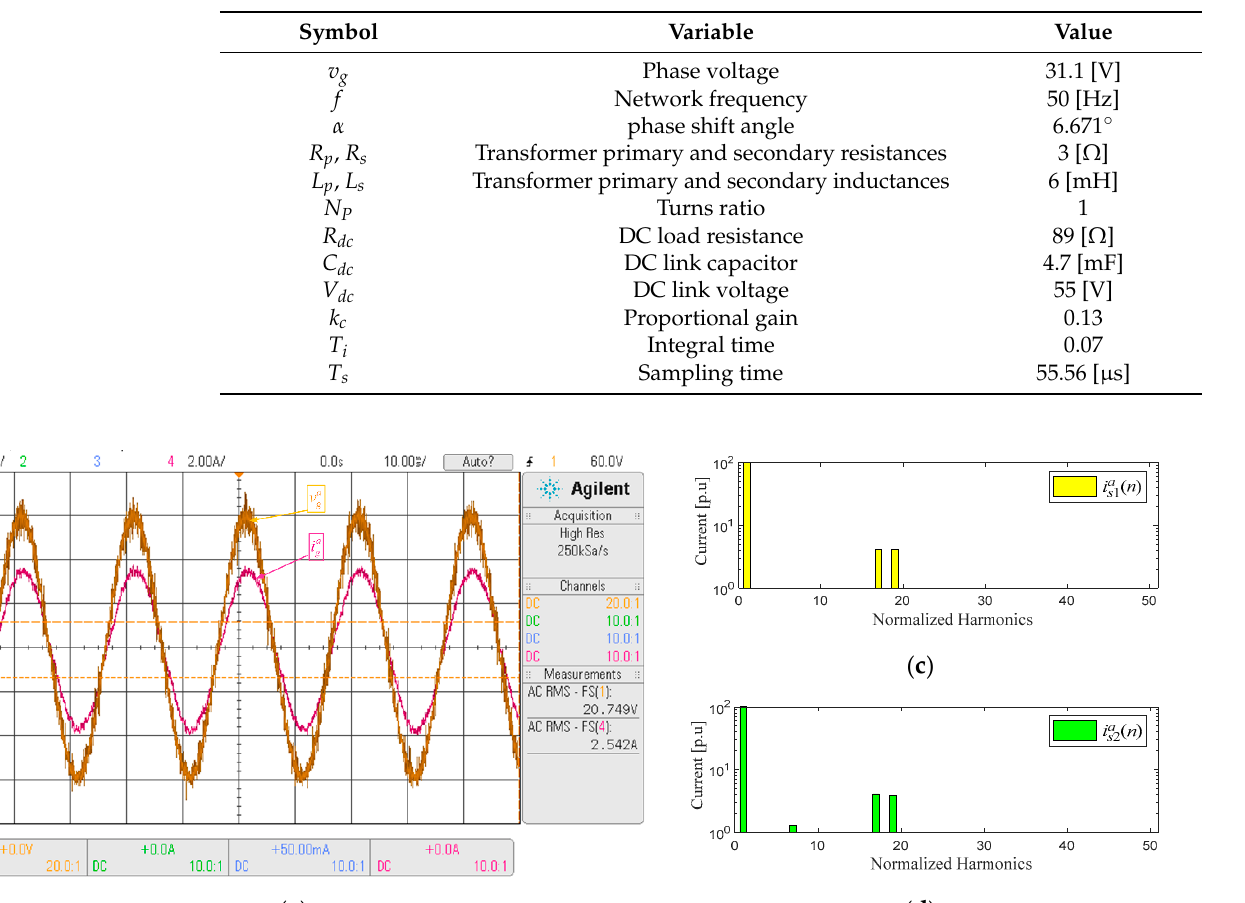
Table 4. Experimental Parameters.